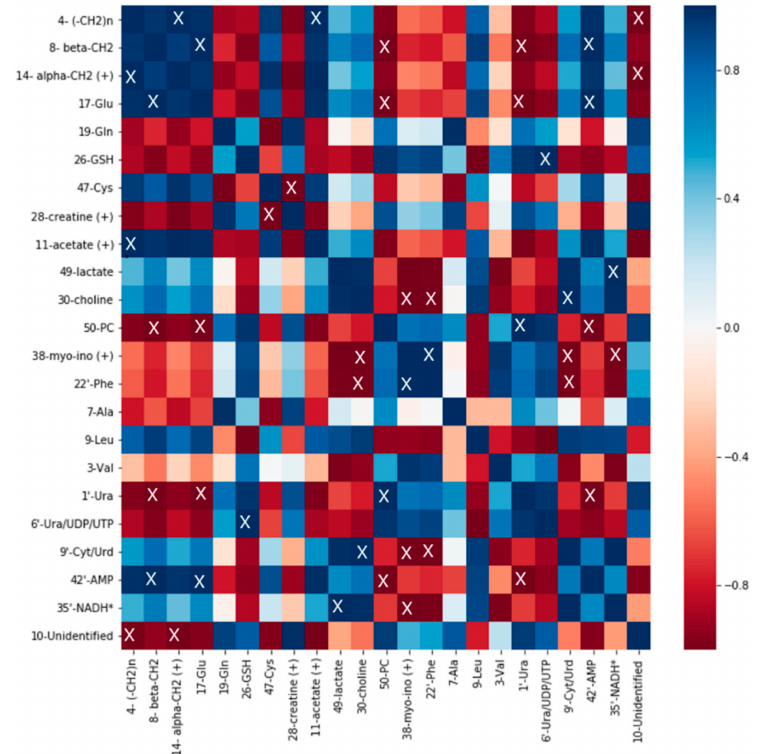
Figure 8. Heatmap of A2780cisR cells treated with 0.03 µ M of DiRu-1 vs. control: The blue color scale has been used for positive correlation, and the red scale is for negative correlation. “X” indicates significances with p -values < 0.05. * Tentative assignment. ( + ) stands for the possibility that some other metabolite is contained in the bucket in question in addition to the assigned